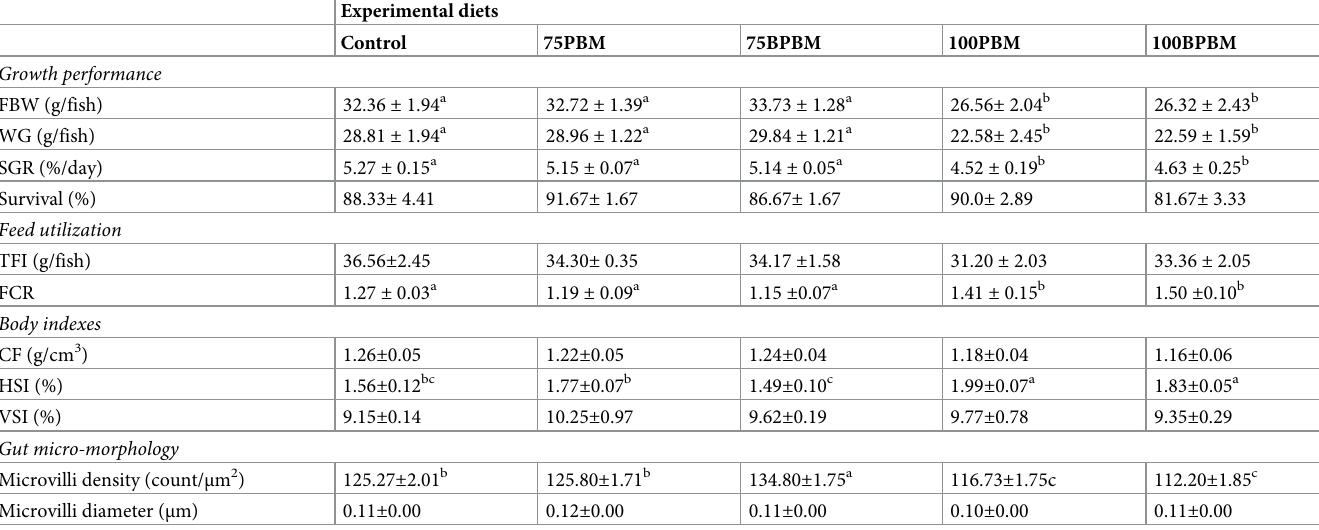
Table 4. Growth performance, feed utilization and gut micro-morphological indices of juvenile barramundi fed with different levels of bioprocessed and unpro- cessed PBM. Experimental